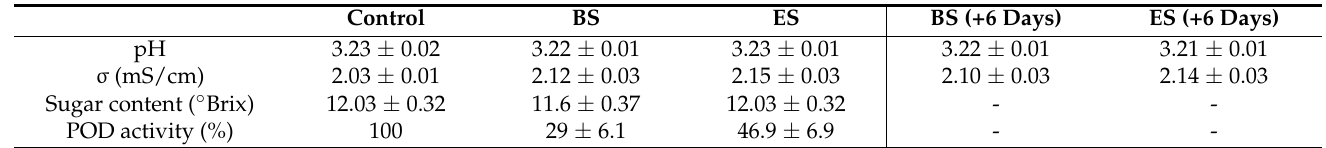
Table 1. Selected juice sensory properties of non-treated and air transient spark treated fresh apple juice in the electrospray system (ES) and the batch system (BS), which were measured directly post plasma exposure and after 6 days (mean ± SD, n =